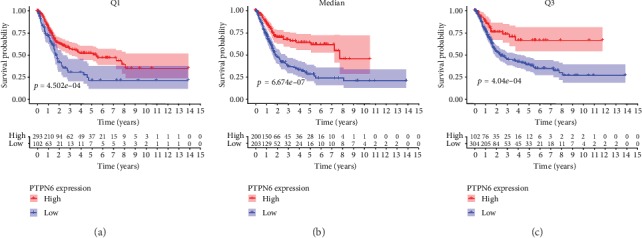
Survival analysis of PTPN6 in BC. Kaplan-Meier curve revealed that low expression of PTPN6 was significantly related to poor OS in BC (Q1, median, Q3; P = 4.502e − 04, 6.674e-07, 4.04e-04) (a–c).